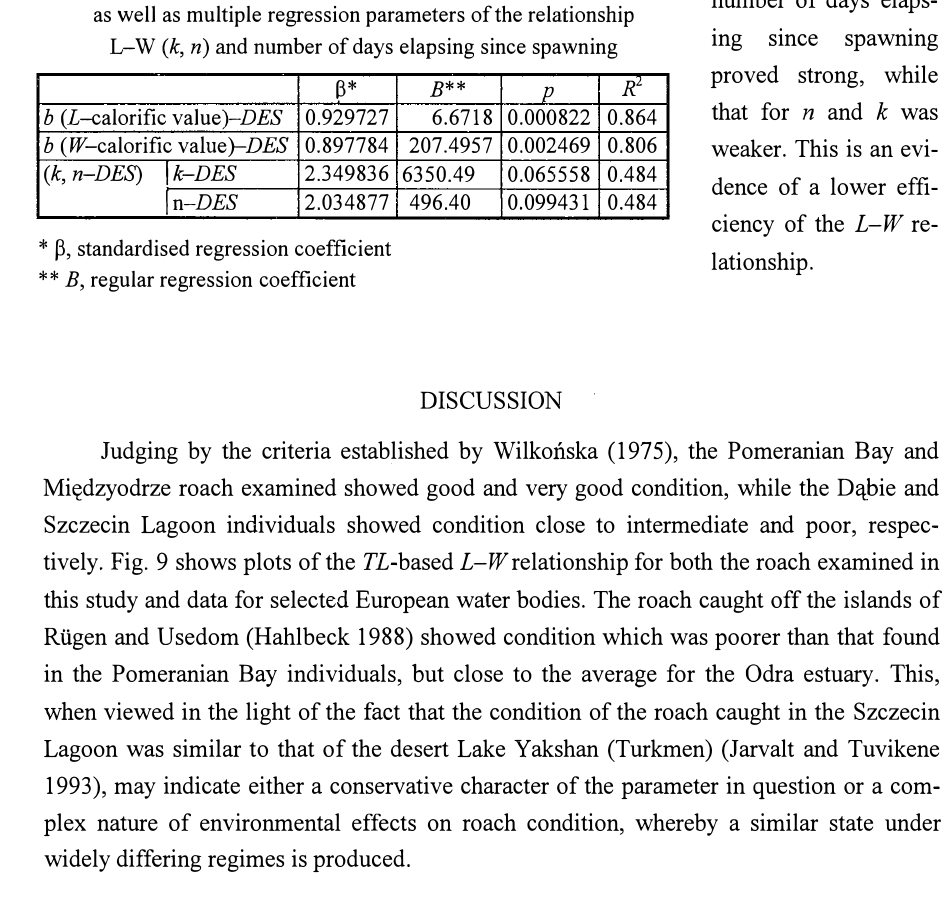
Linear regressions of regression coefficients. b